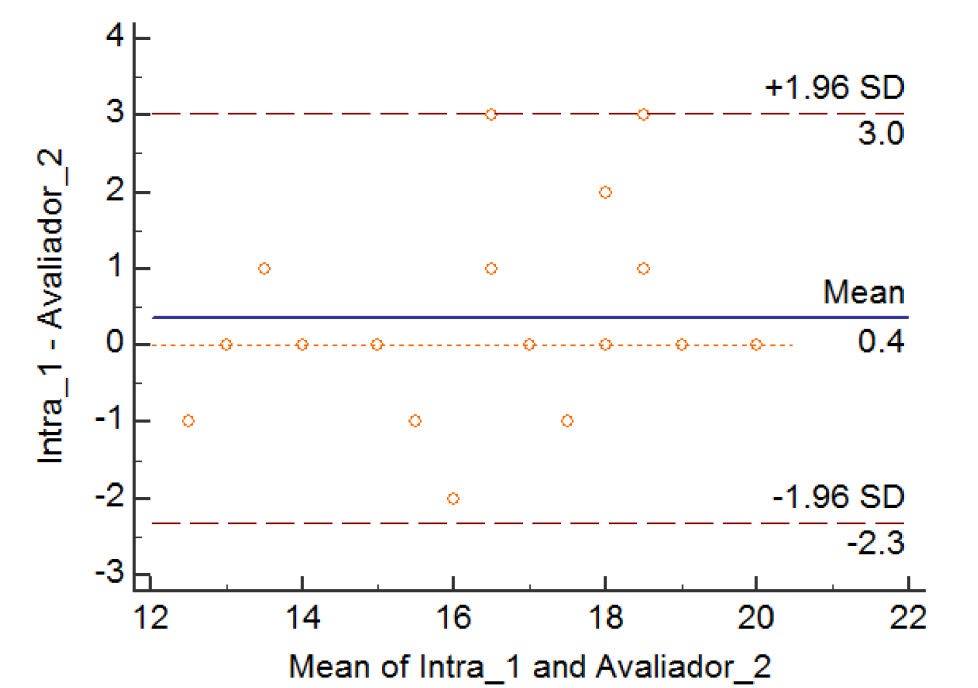
Figure 3 - Bland & Altman Confidence limits. No outliers. Reviewer Intra_1 = 1 at first; Reviewer Avaliador_2 = 2 at